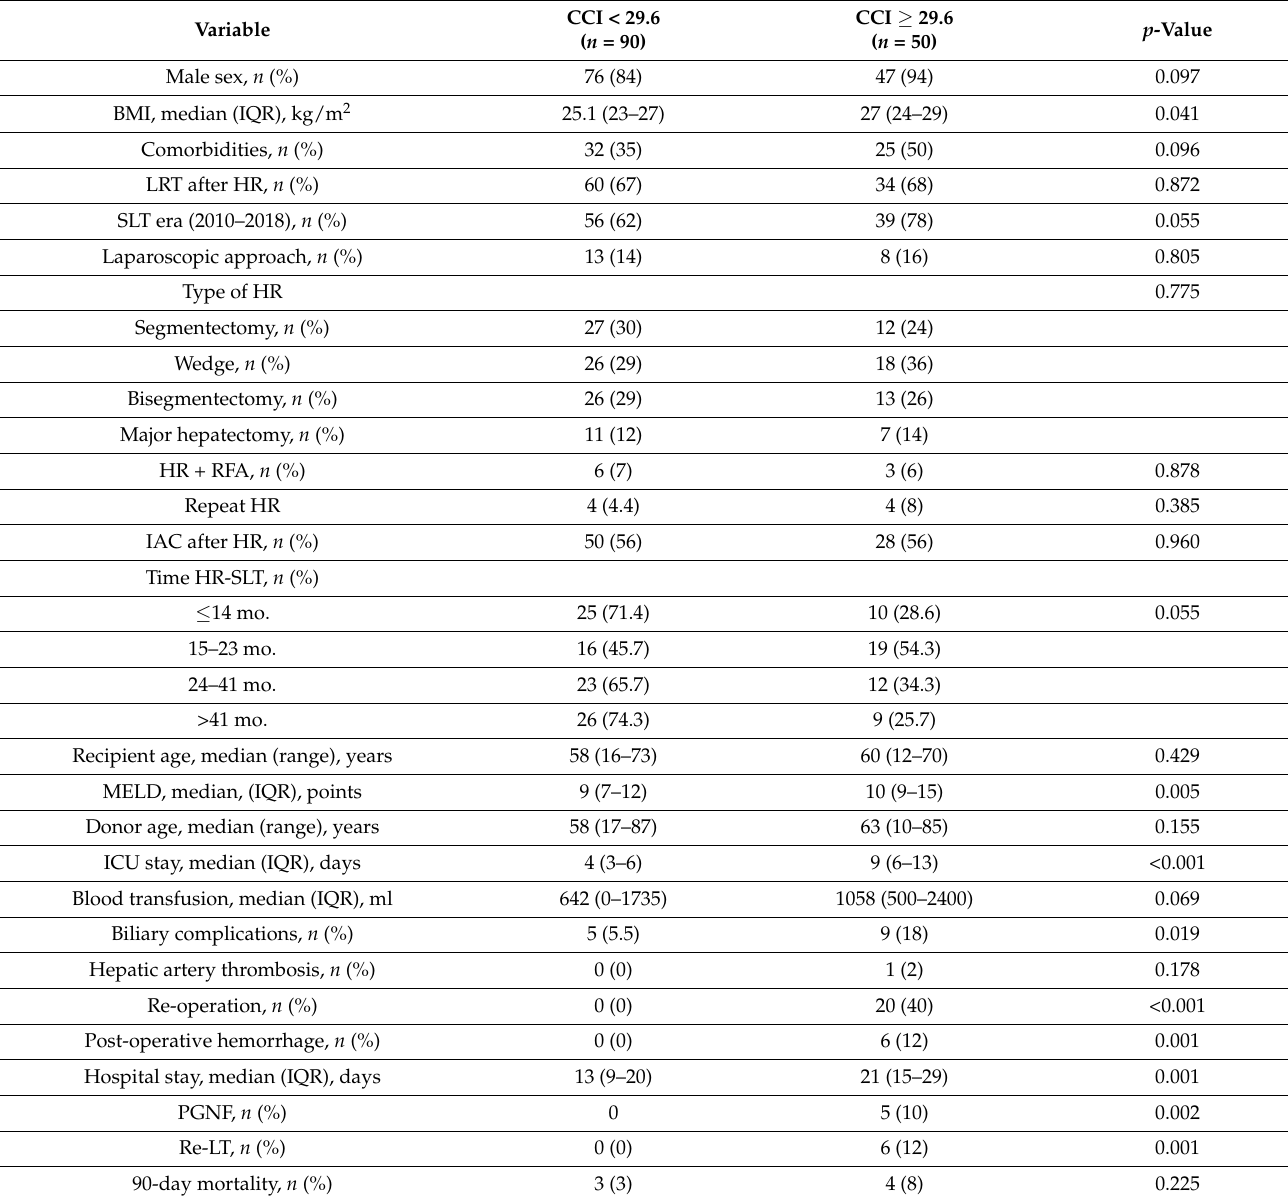
Table 3. Characteristics of patients with or without severe complications (Comprehensive Complication Index CCI ≥